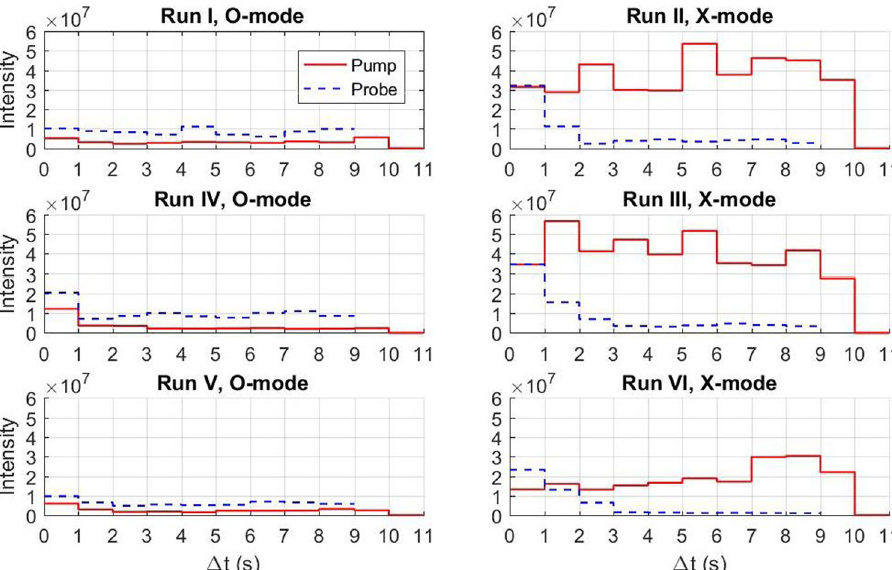
Fig. 3 Pump and probe intensities. Intensities (arb. units, linear scale) of the central spectral components of the returned pump and probe signals in Fig. 2 at different times, comparing O (left) and X (right) mode runs. Probe frequencies are given in Table